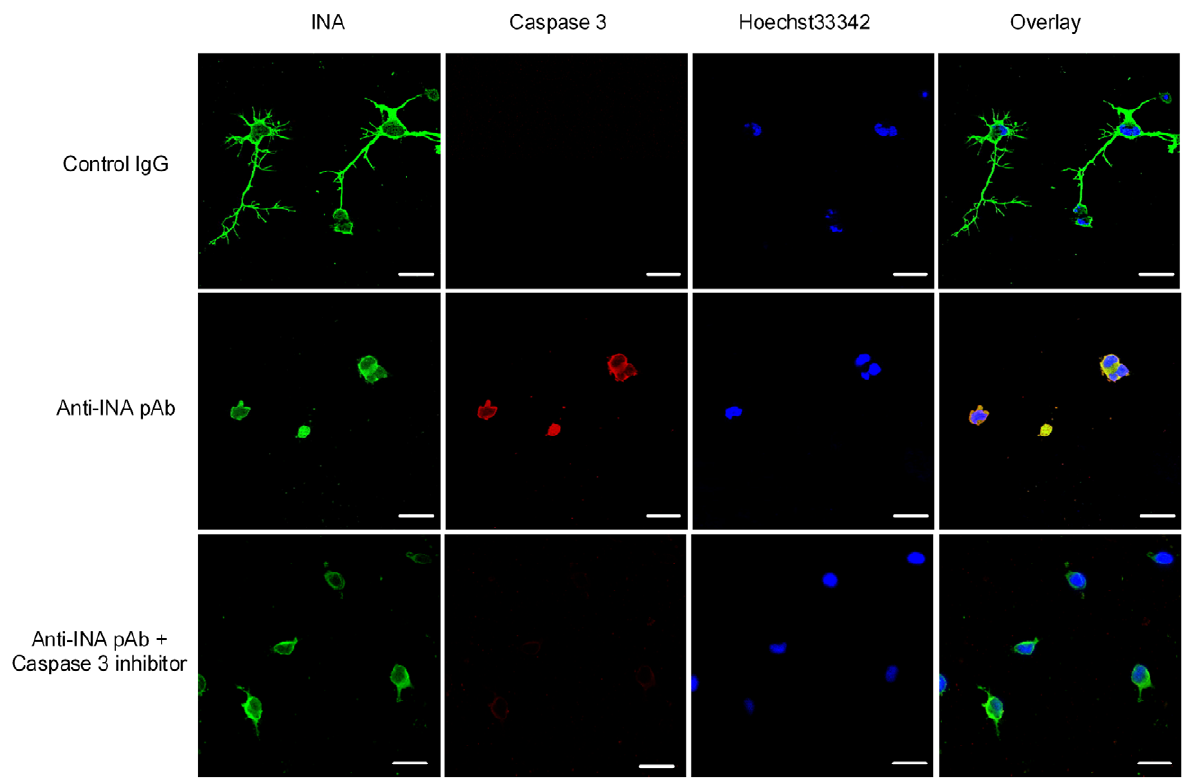
Figure 7. Apoptosis with caspase-3 activation is the downstream effect of anti-INA mediated neuron damage. Primary rat cortical neurons were co-cultured with anti-INA pAb or control IgG for 24 h. Caspase-3 inhibitor was added as indicated. The cells were triple-labeled Hoechst (blue), caspase-3 (red), and INA (green). (Scale bar =10 m m).